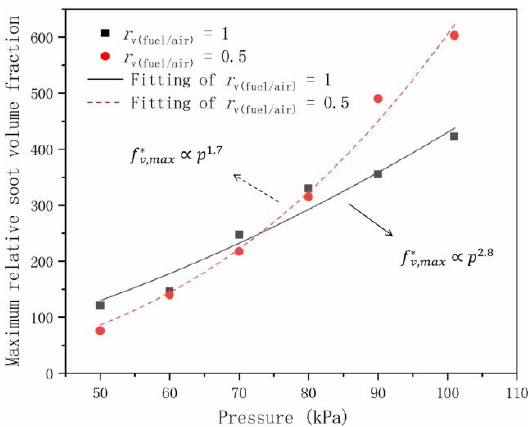
Figure 8. Maximum relative soot volume fraction as a function of pressure.